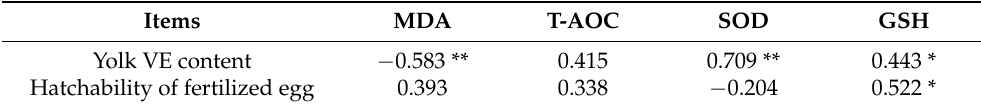
Table 10. Correlation analysis of vitamin E (VE) content, hatchability of fertilized egg, and antioxidant capacity index in egg yolk 1